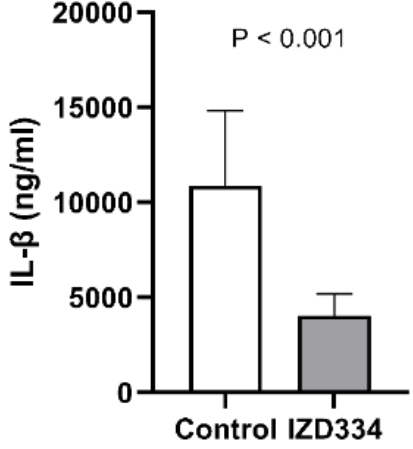
Figure 2. Ex vivo stimulation assay after in vivo IZD334 infusion. IL- 1β release was significantly reduced when porcine whole blood was stimulated ex vivo after infusion of IZD334 .